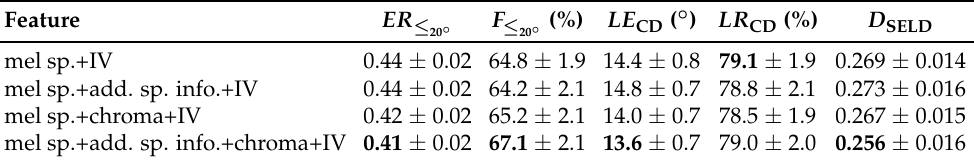
Table 3. Ablation study on input features for our DCMA-SELD on the TNSSE 2021 development dataset. All data represent mean values and associated 95% confidence intervals. The highest performance in each metric is indicated in bold.